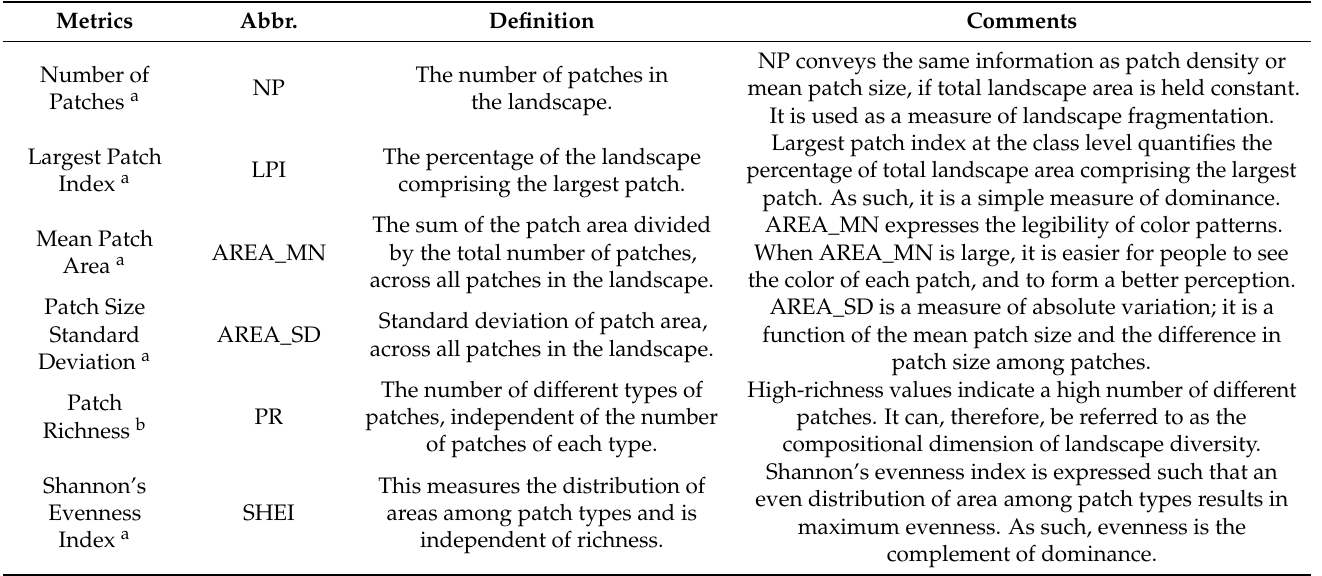
Table 2. The selected metrics for describing the characteristics of spatial color